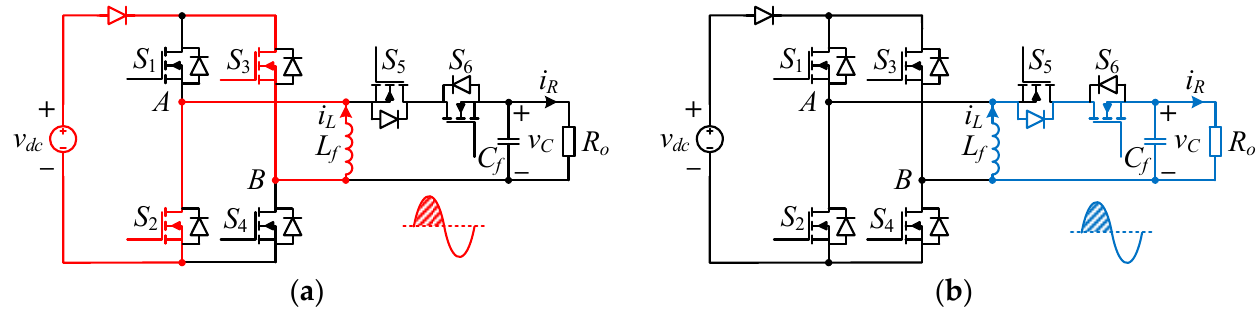
Figure 2. Switching patterns for the positive half-wave of v c : ( a ) Inductor charged, ( b ) Inductor dis- charged.